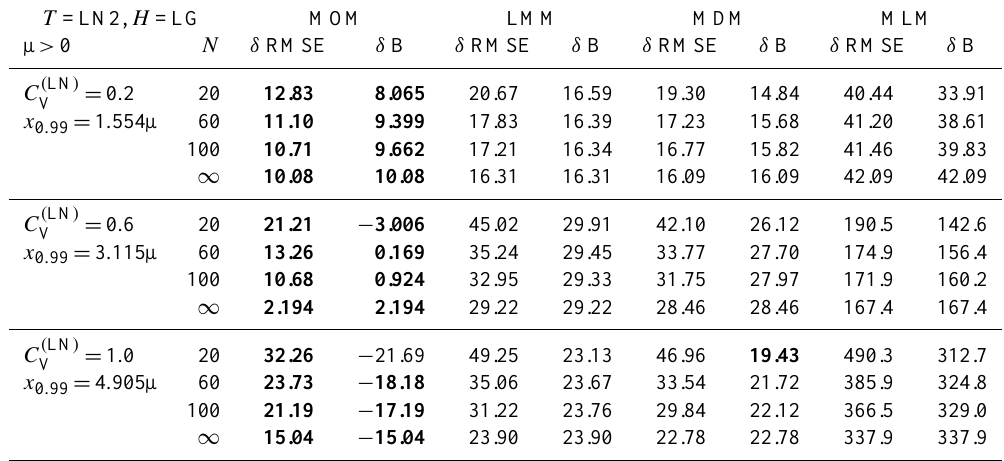
Table 7. Relative accuracy [ % ] of ˆ x 0 . 99 for a sample from LN2, assuming LG model.